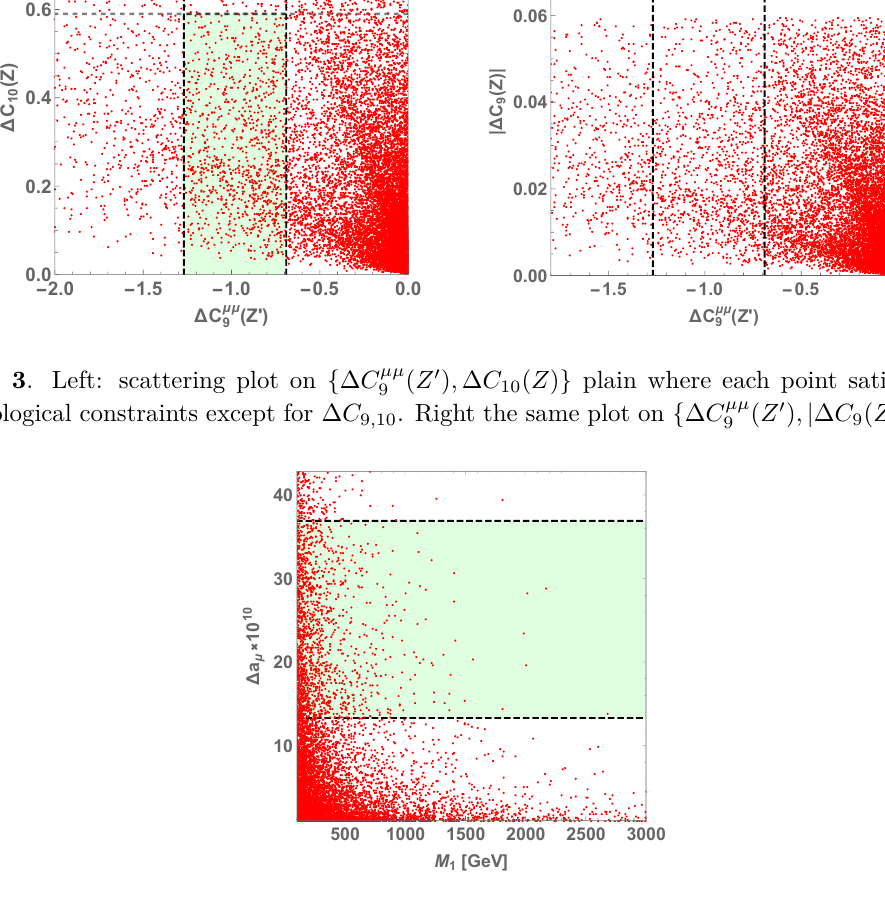
Figure 4 . M 1 versus ∆ a µ for the parameter sets same as the previous plots.